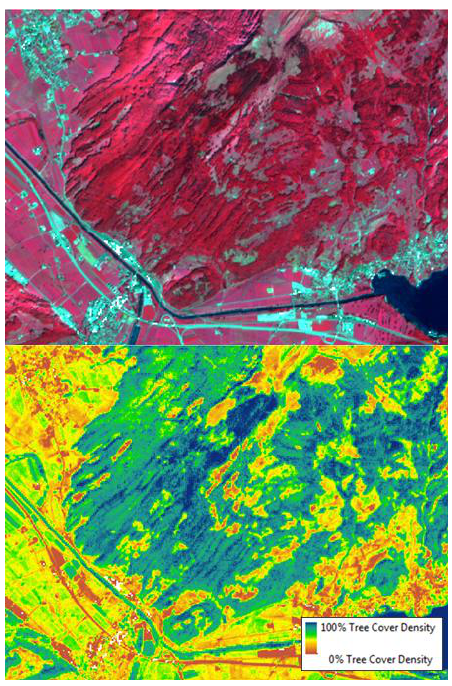
Figure 2. Multi-temporal S-2 feature stack (upper figure) and the derived TCD